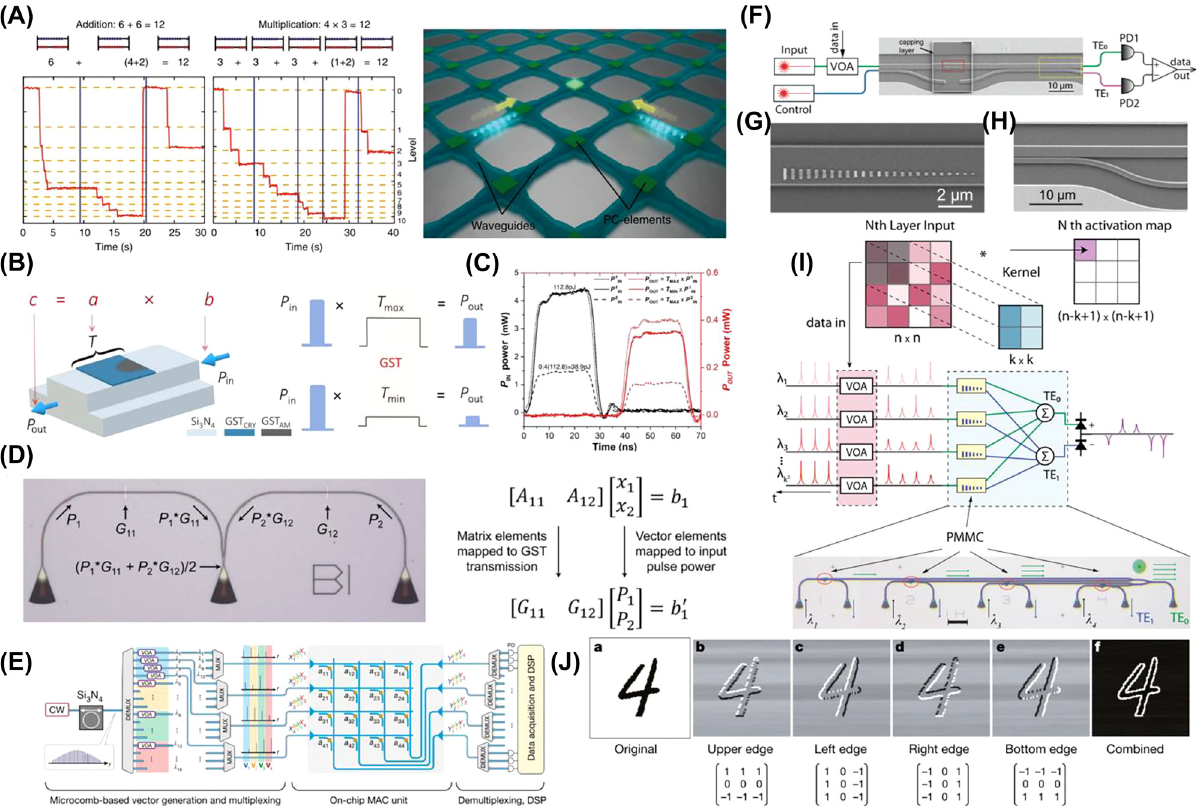
Figure 15: In-memory computing using PCMs. (A) An on-chip all optical abacus [168]. Left: A base-10 addition of ‘ 6 + 6 = 12 ’ is calculated. Middle:Multiplicationof ‘ 3 × 4 = 12 ’ ,equivalenttosequentialaddition,iscalculated.Right:Thewaveguidecrossingarray.PCMsareplacedat every crossing point and can only be switched when two overlapping pulses are applied. (B – D) Demonstration of direct scalar multiplication andmatrix – vectormultiplicationonaphotonicplatform[169].(B)Bymappingthemultiplicand ‘ a ’ totransmittance( T )andthemultiplier ‘ b ’ to input power ( P in ), answer ‘ c ’ can be obtained by measuring the output power ( P out ) as P out = T ( P write ) × P in . (C) Real-time measurement of the input andoutput pulses for threemultiplication operations. (D) Opticalimage of the circuit design to implementmatrix – vector multiplication. (E) and (J) An integrated photonic tensor core consisted of phase-change memory cells to perform convolutional image processing [157]. (E) Conceptual illustration of an architecture that incorporates the photonic tensor core to compute convolutional operations. (J) Four image kernels of size 3 × 3 each highlighting a different edge of the original image. (F – I) A programmable phase-gradient metasurface mode converter (PMMC) that is scalable to realize an optical convolutional neural network (OCNN) [55]. (F) SEM image of the PMMC and the corresponding setup for device programing and measurement. (G) Zoomed-in SEM image to show the geometry of the GST nano-antenna. (H)ThemodeselectorthatcancoupletheTE 1 modeout ofthebuswaveguide.(I)Operationprincipleforconvolutional imageprocessingusing a PMMC array. Kernels of dimensions k × k are encoded into k 2 number of PMMCs. Pixels of the input image are grouped into ( n − k + 1 ) 2 patches that are encoded as optical